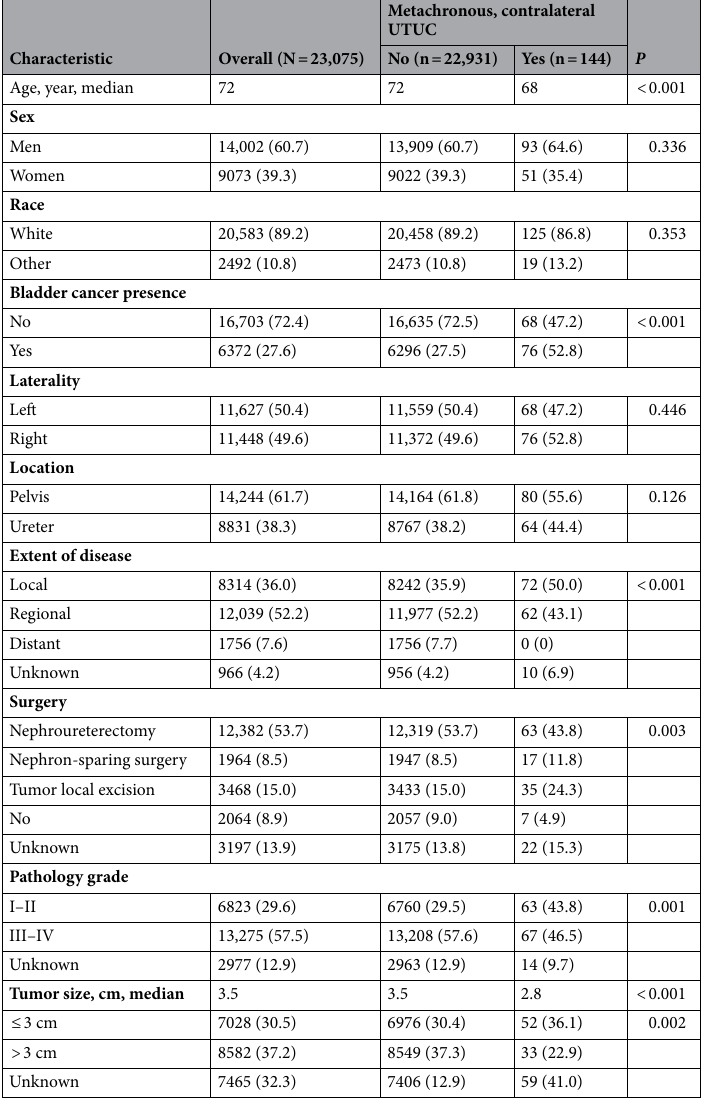
Table 1. Clinicopathologic characteristics of patients who developed a new, metachronous contralateral UTUC. Data are presented as n (%) unless noted otherwise. UTUC upper tract urothelial carcinomas.